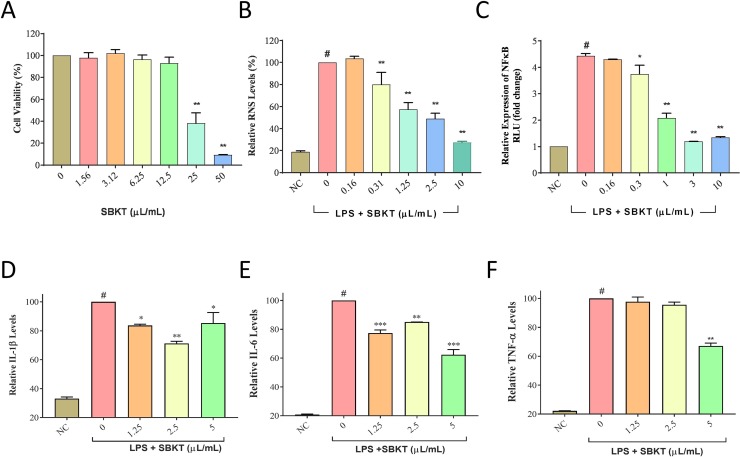
In vitro anti-inflammatory potentials of the SBKT. (A) Treatment of THP-1 cells with SBKT induced loss of cell viability at concentrations ≥25 μl/ml. Treatment of the lipopolysaccharide (LPS)-stimulated THP-1 cells with the non-cytotoxic doses of SBKT showed amelioration in the production of (B) reactive nitrogen species (RNS) and (C) NF-κB. Downstream reduction in the release of pro-inflammatory cytokines: (D) interleukin-1ß (IL-1ß), (E) interleukin-6 (IL-6), and (F) tumor necrosis factor-α (TNF-α) was observed in the LPS-stimulated THP-1 cells treated with different concentrations of SBKT. These experiments were performed thrice in triplicates. One-way ANOVA followed by Dunnett’s post hoc test was performed to calculate statistical significance. #p < 0.001 (LPS-stimulated versus normal control cells); *p < 0.05, **p < 0.01, ***p < 0.001 (LPS only stimulated cells versus LPS + SBKT-treated cells).